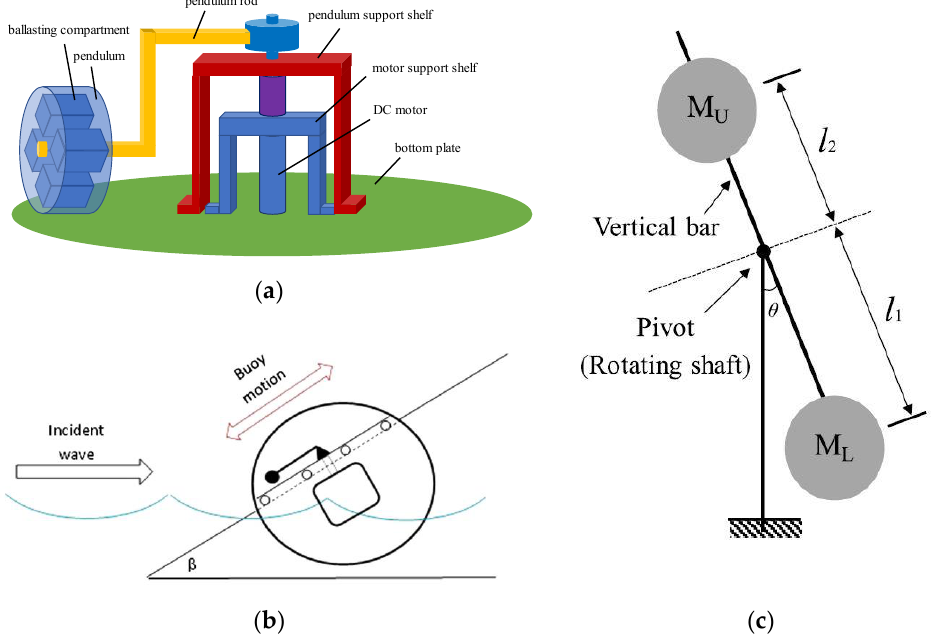
Figure 3. ( a ) Low-frequency horizontal pendulum ocean kinetic energy harvester [48]. ( b ) Parametric pendulum wave energy converter [49]. Reprinted with permission from Ref. [49]. Copyright 2017, Elsevier. ( c ) Double-mass pendulum oscillator [50]. Adapted with permission from Ref. [50]. Copyright 2021, Elsevier.